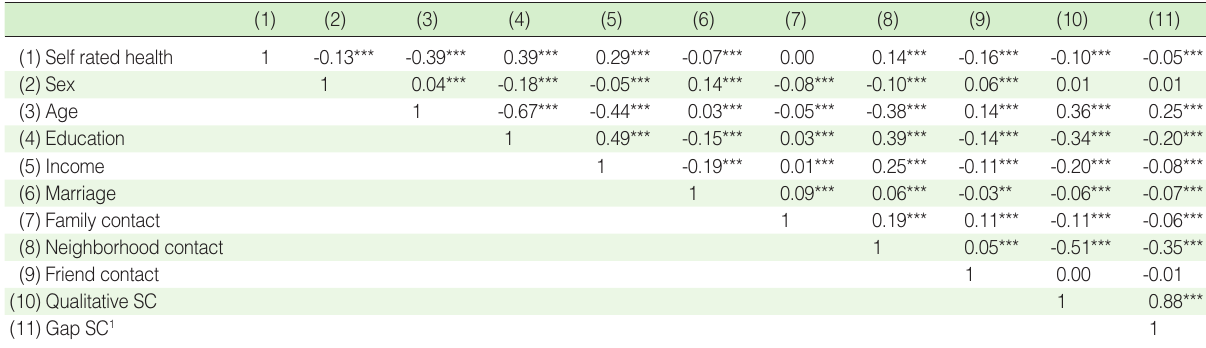
Table 2. Correlation between variables